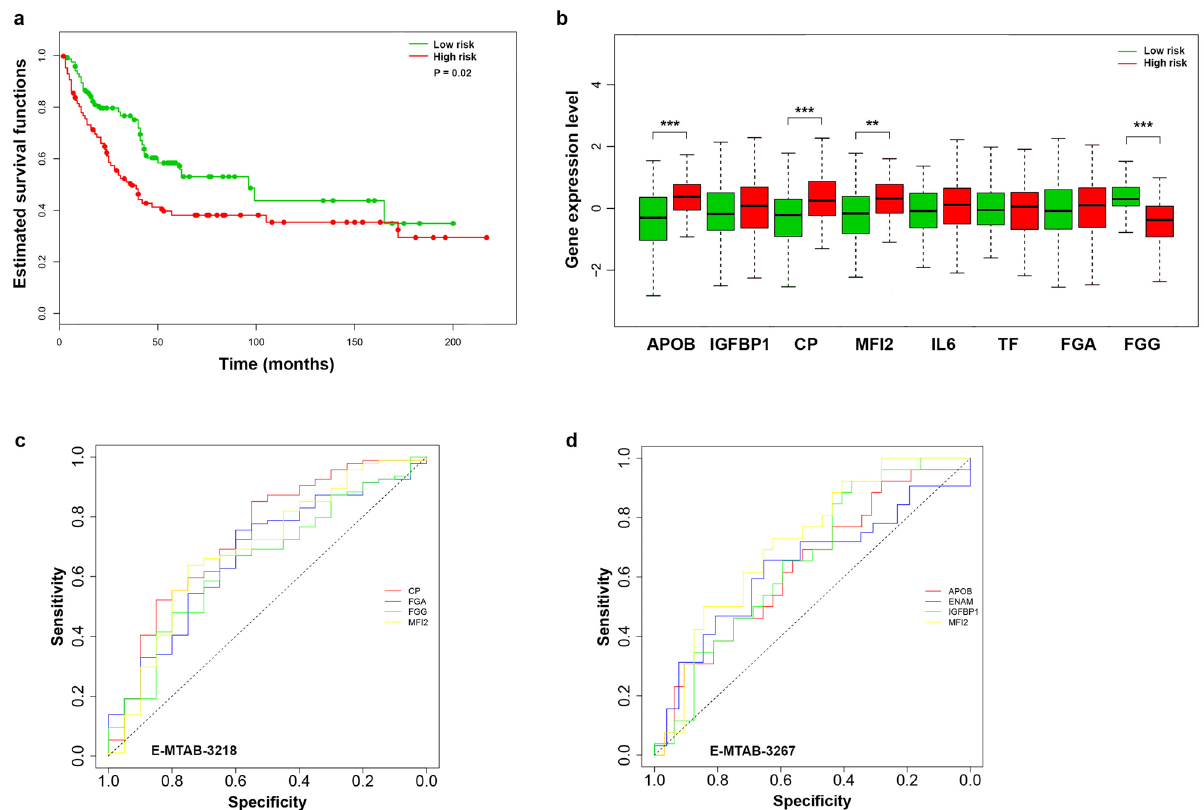
Figure 5. Analysis of the survival rate of the hub genes on an independent sample. Kaplan–Meier curve for the GSE3538 dataset ( a ). Expression of eight hub genes in high (red) and low risk (blue) groups ( b ). *** P < 0.001; ** P < 0.001. ROC curves for four hub genes associated with response to nivolumab ( c ) and sunitinib ( d